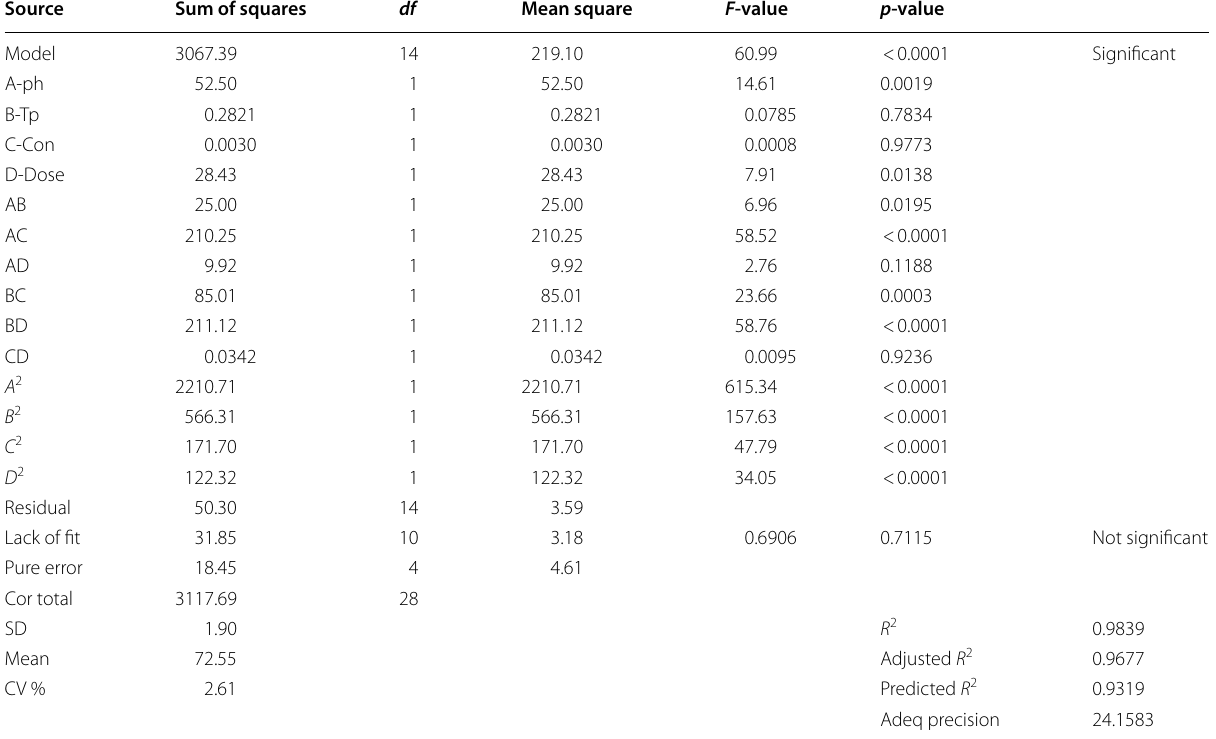
Table 11 Analysis of variance (ANOVA), results for decolourization of MG by immobilized Mucor sp. Source Sum of squares df Mean square F ‑value Model